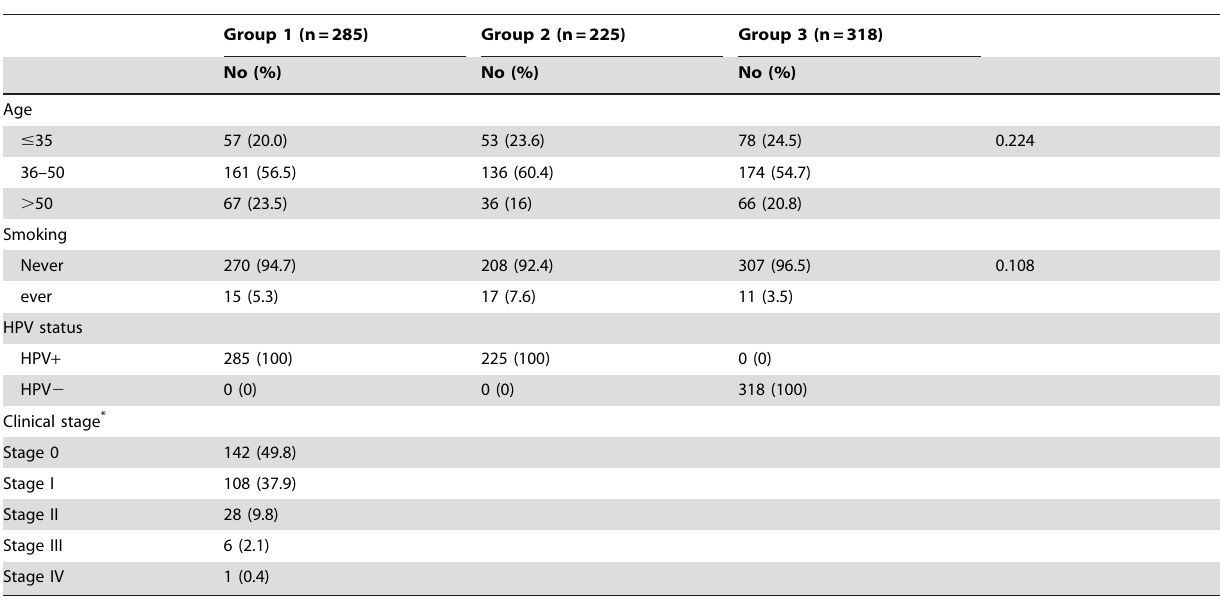
Table 1. Baseline clinical characteristics of involved groups.